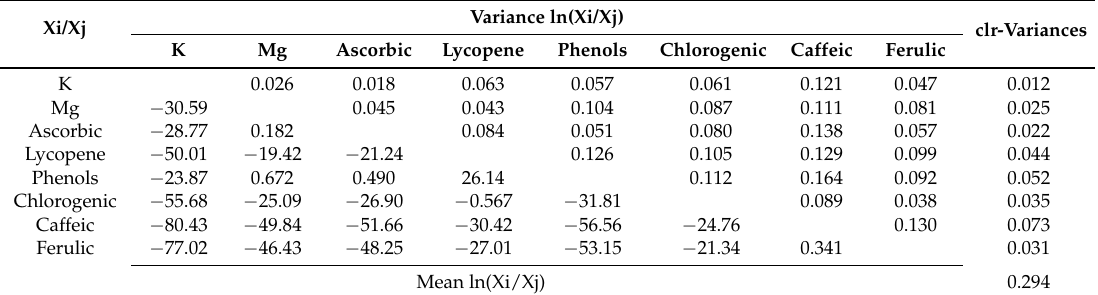
Table 3. Variation array of functional compounds (The upper triangle contains the log-ratio variances and the lower diagonal contains the log-ratio means). Variance Xi/Xj